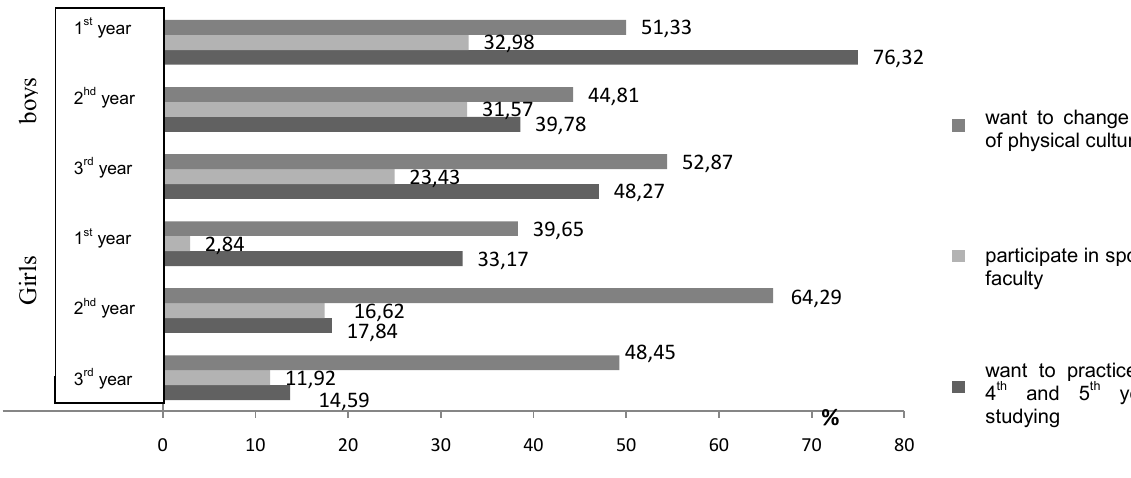
Fig.10. Opinions about changes in physical culture and participation in faculty’s sport life